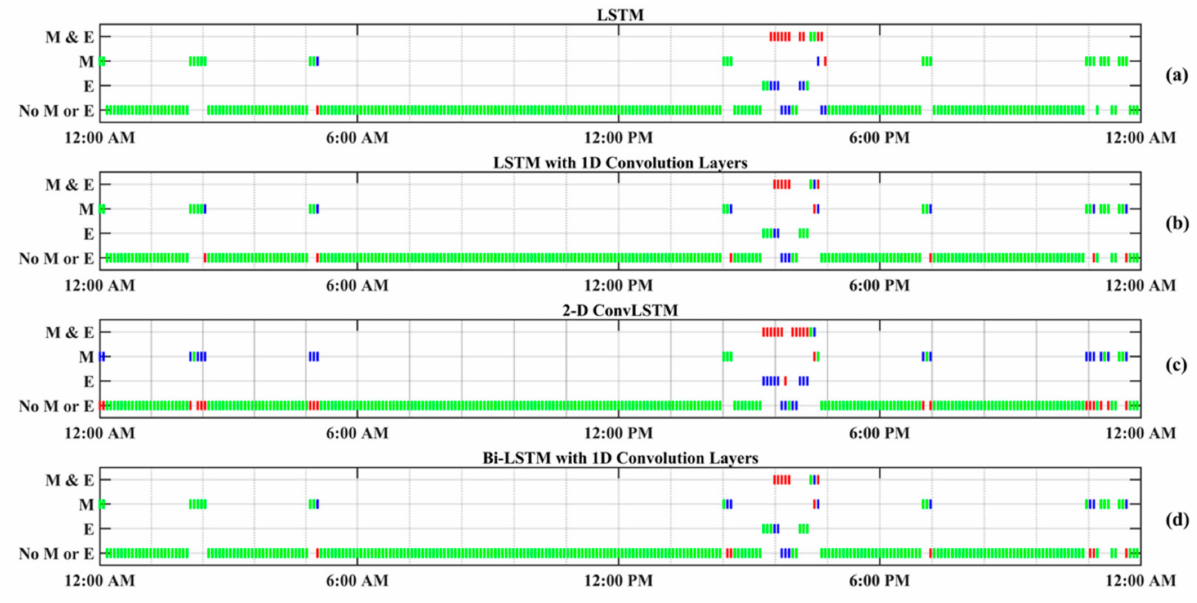
Figure 8. Meal and exercise events were predicted for one person (subject 2) with outliers and unimputed samples by using different RNN configurations. Vertical green bars represent correctly predicted classes. Vertical red bars denote incorrectly predicted classes, and their actual labels are shown by blue bars. ( a ) LSTM, ( b ) LSTM with 1D Convolution Layers, ( c ) 2DConvLSTM, ( d ) Bi-LSTM with 1D Convolution Layers